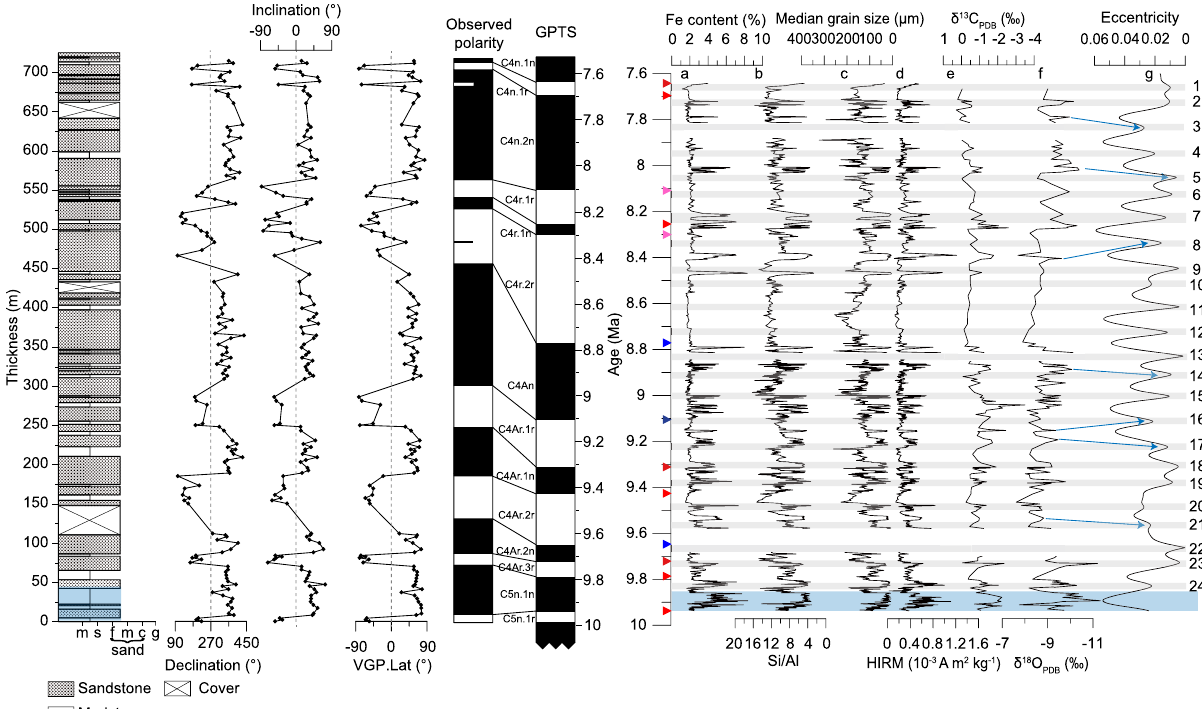
Fig. 2 Lithology, age model, and paleoenvironmental proxy records from the studied section. The left panel shows the lithology and paleomagnetic age model. The right panel shows paleoenvironmental proxy records. a Fe content. b Si/Al. c Median grain size. d HIRM. e δ 13 C PDB . f δ 18 O PDB . g Eccentricity 24 . Gray bars show the disappearance of eolian dune strata during low eccentricity. The blue shadow highlight dominant wet environment over the lower ~50 m of the strata. The triangles show reversals recorded by this section, with red, purple, and blue ones corresponding to tightly (<20 kyr), mediumly (35 – 40 kyr), and loosely (75 – 125 kyr) constrained reversals, respectively. Numbers on the right indicate eccentricity lows from top to